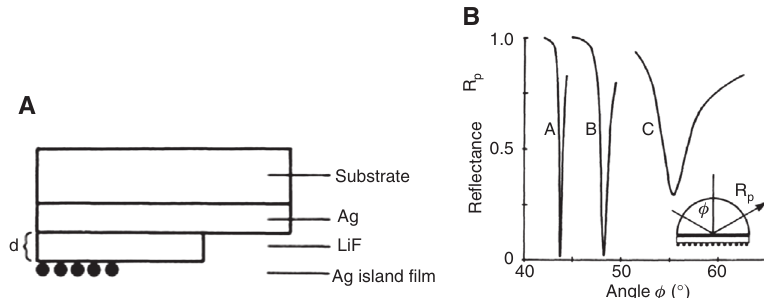
Figure 5: (A) Sample geometry used in the experiment of Holland and Hall [26]. The continuous silver film has a thickness of 50 nm. The thickness of the LiF spacer layer d was varied between 5 and 60 nm. The silver-island film had a mass thickness of 3 nm. (B) Measured reflectivity R , as a function of the angle in the prism. In this case, the excitation wavelength was 514.5 nm and the spacer-layer thickness p d = 20 nm. A: Ag-air; B: Ag-LiF-air; C: Ag-LiF-Ag islands-air. Insert shows ATR geometry. Reprinted figure with permission from W. R.